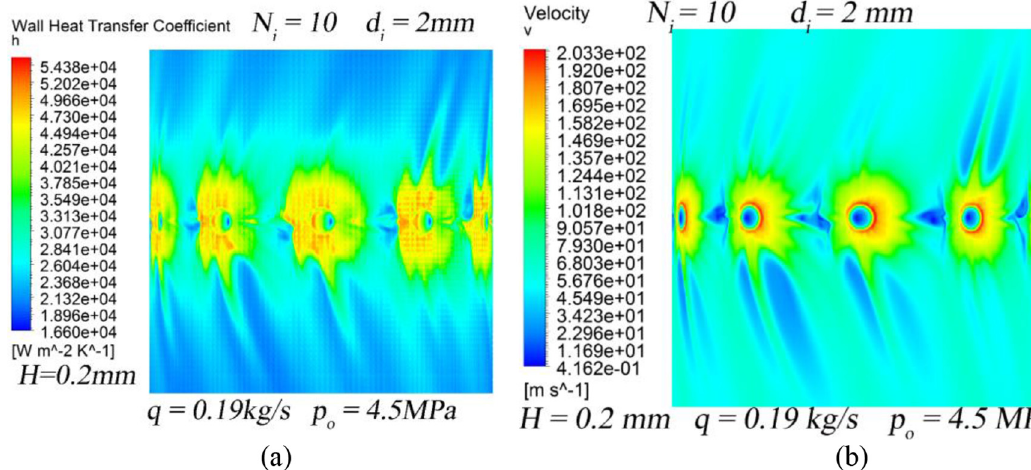
Fig. 7. Heat transfer coef fi cient vs fl ow velocity distributions. (a) Surface heat transfer coef fi cient. (b) Distribution of the fl ow